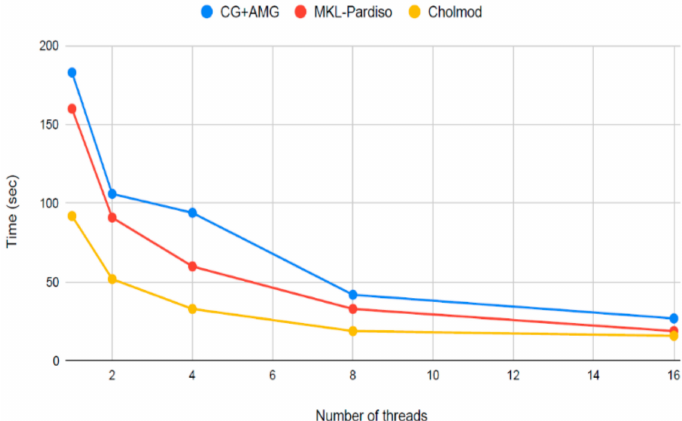
Figure 4. Increases in computational speed for Omniscape.jl from parallel processing via multi- threading (deployment of moving window-sized calculations to different CPUs) scales well as the number of simultaneous processes (threads) increase [51]. The benchmark problem was a 132,642 pixel grid, run with a block size of 21, and a moving-window radius of 100 pixels (approximately 34,000 pixels per window, and 300 window-sized runs). Scaling was evaluated for three different solvers that are available in the software, the CG + AMG (preconditioned conjugate gradient with algebraic multigrid preconditioner) in blue, Suitesparse’s CHOLMOD solver in orange, and Pardiso compiled with Intel Math Kernel Library (MKL [187]) in red. Produced on an Intel(R) Xeon(R) Silver 4114 CPU @ 2.20 GHz with 20 cores and 64 GB RAM. The Julia version is 1.6.0-dev Commit 599d3299c9, compiled with